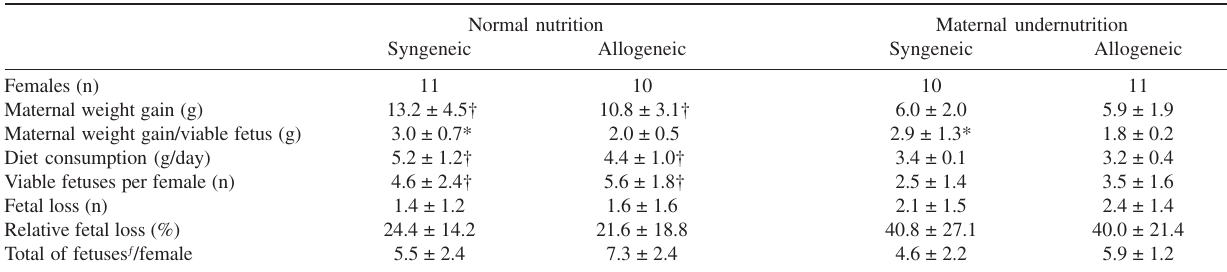
Table 2 - Description of animal numbers, maternal weight gain, diet consumption, number of viable fetuses per female, and total and relative fetal loss for each study group ( mean ± SD)